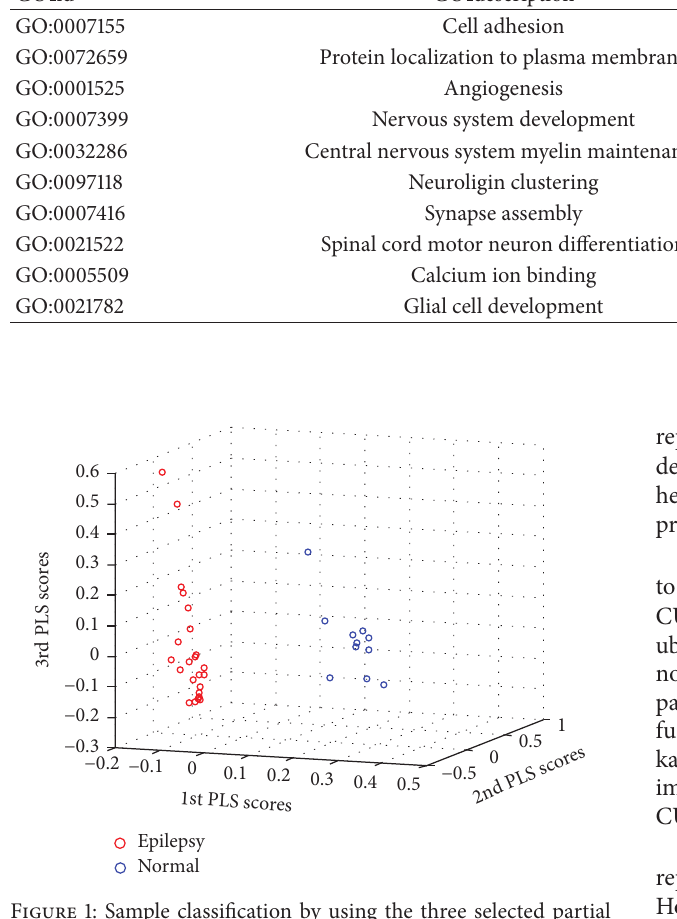
Figure 1: Sample classification by using the three selected partial least squares (PLS) latent